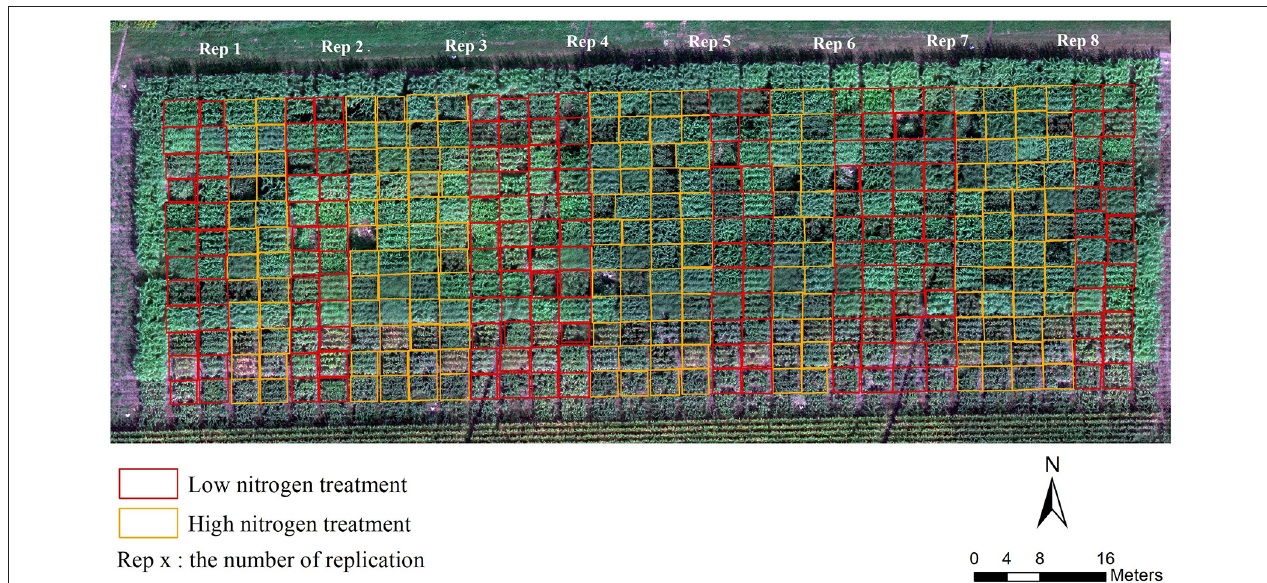
FIGURE 2 | True-color orthomosaic showing field design. Images collected on September 11,